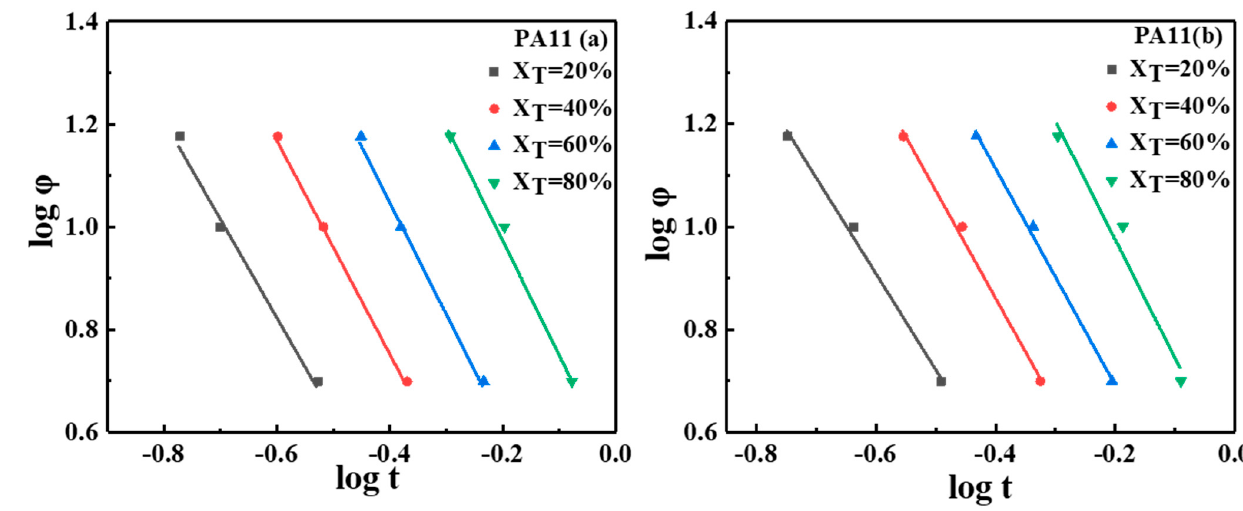
Figure 7. Plot of 𝑙𝑜𝑔𝜑 versus 𝑙𝑜𝑔𝑡 at different relative crystallinity percentages. Figure 7. Plot of log ϕ versus logt at different relative crystallinity percentages. Table 3. The values of 𝑏 and 𝐹(𝑇) at different relative crystallinities.